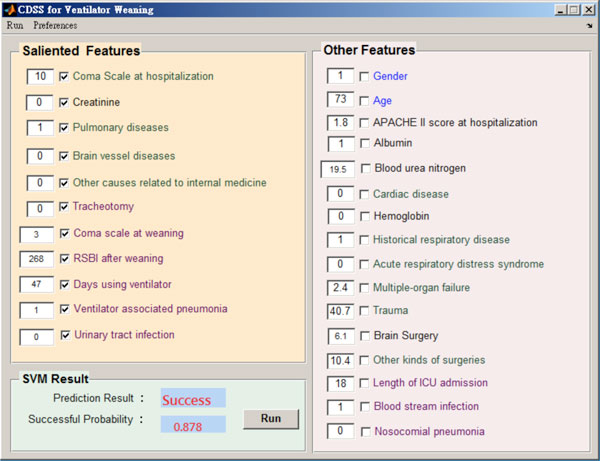
Graphic user interface of the CDSS for ventilation weaning.